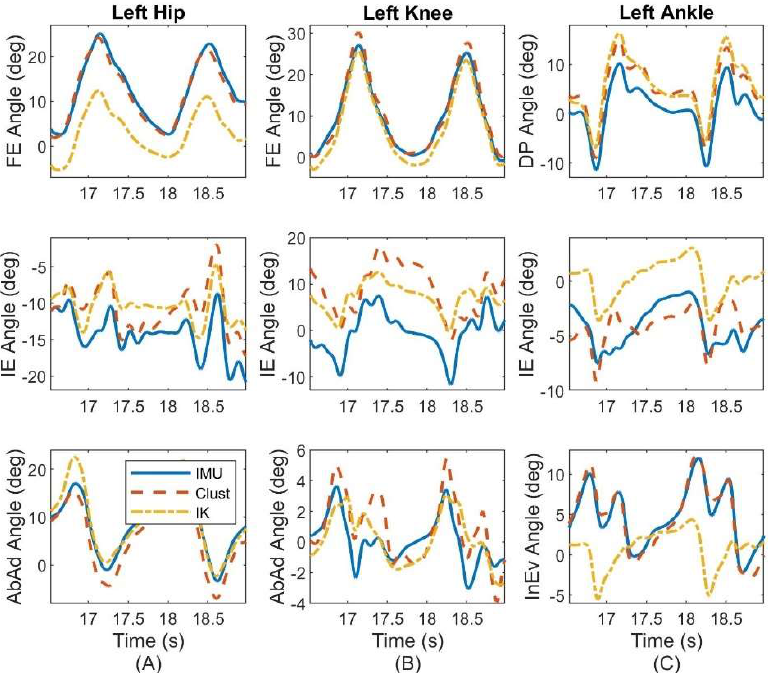
Figure A6. Lateral Right Walking. Example joint angle estimates over two stride cycles for lateral right treadmill walking. Plots show the three anatomical angles for ( A ) left hip, ( B ) left knee, and ( C ) left ankle. Estimates are also compared between ErKF (IMU), cluster (Clust), and inverse kinematics (IK) methods.